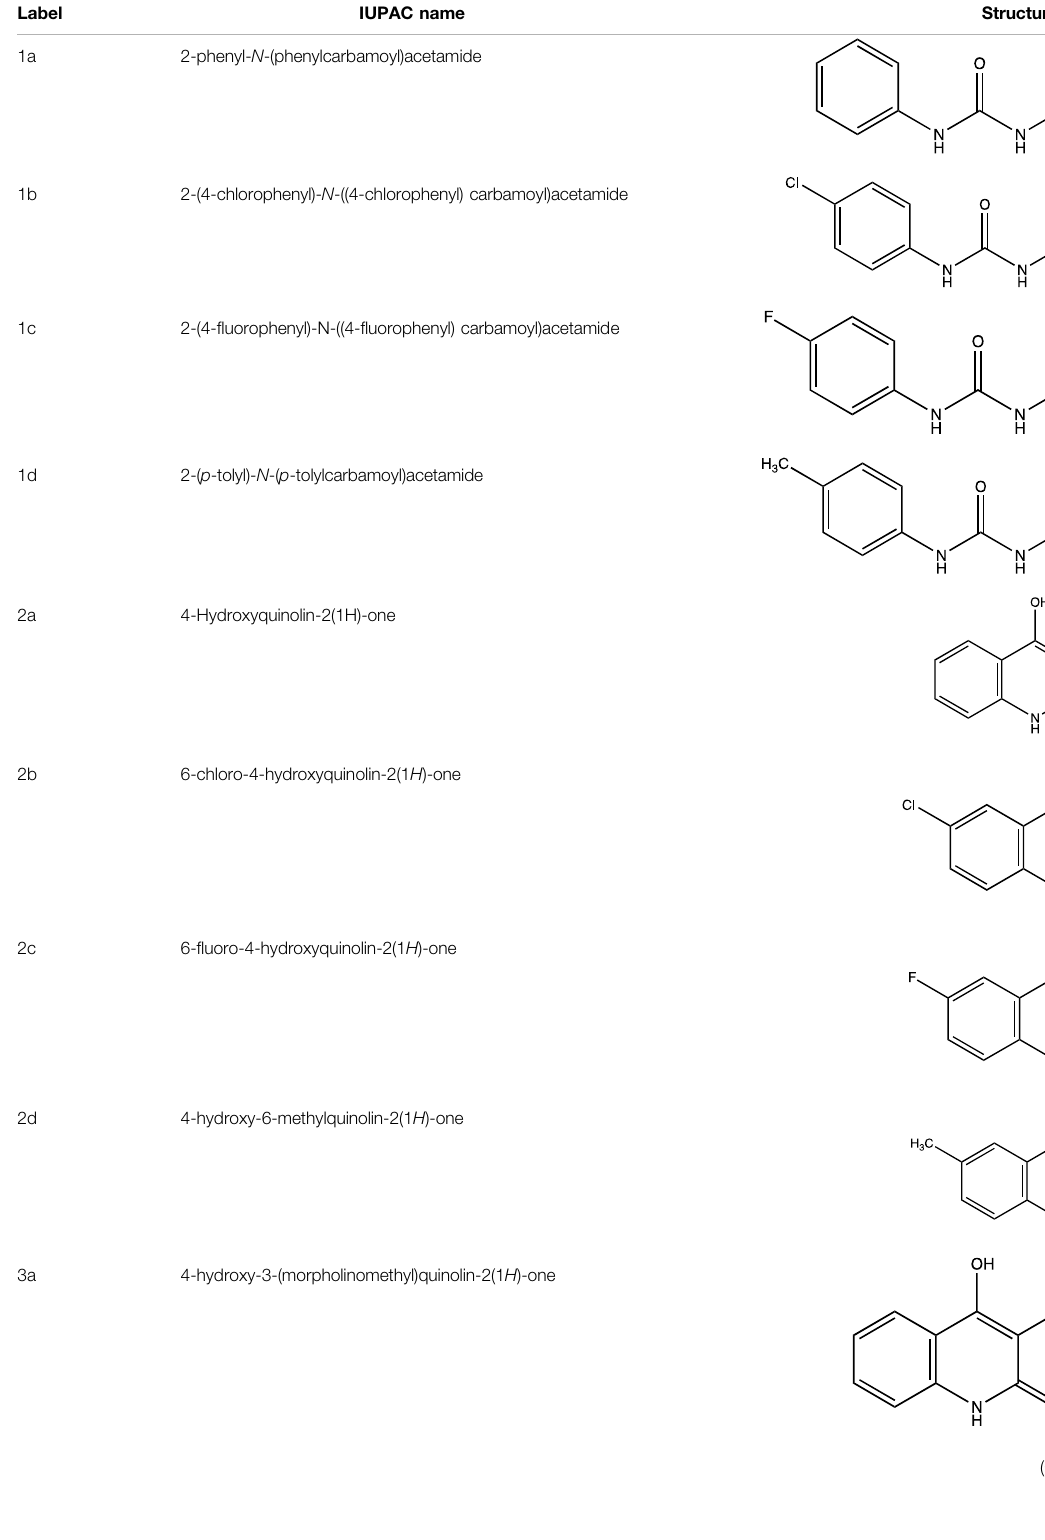
TABLE 1 | Summary of the reagents, intermediates, synthesized compounds, their labels, IUPAC names and functional groups.